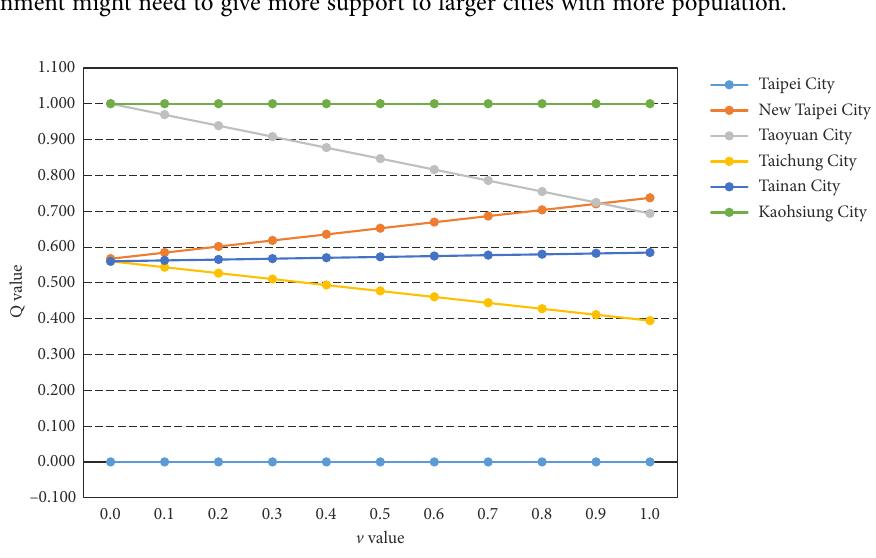
Figure 7. Simulation of the six cities for different v value in total aspects